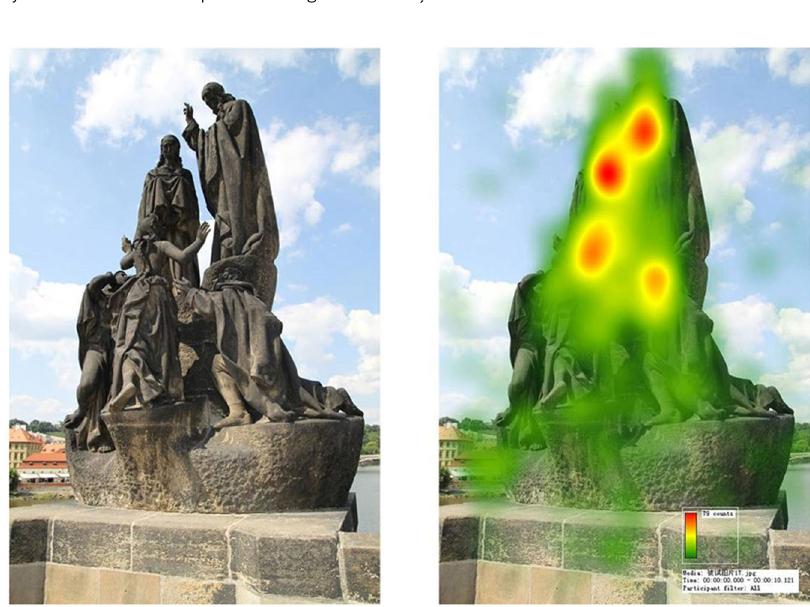
Fig. 15 The comparison of eye motion and heatmap for the city bridge sculpture of Cyril and Methodius.